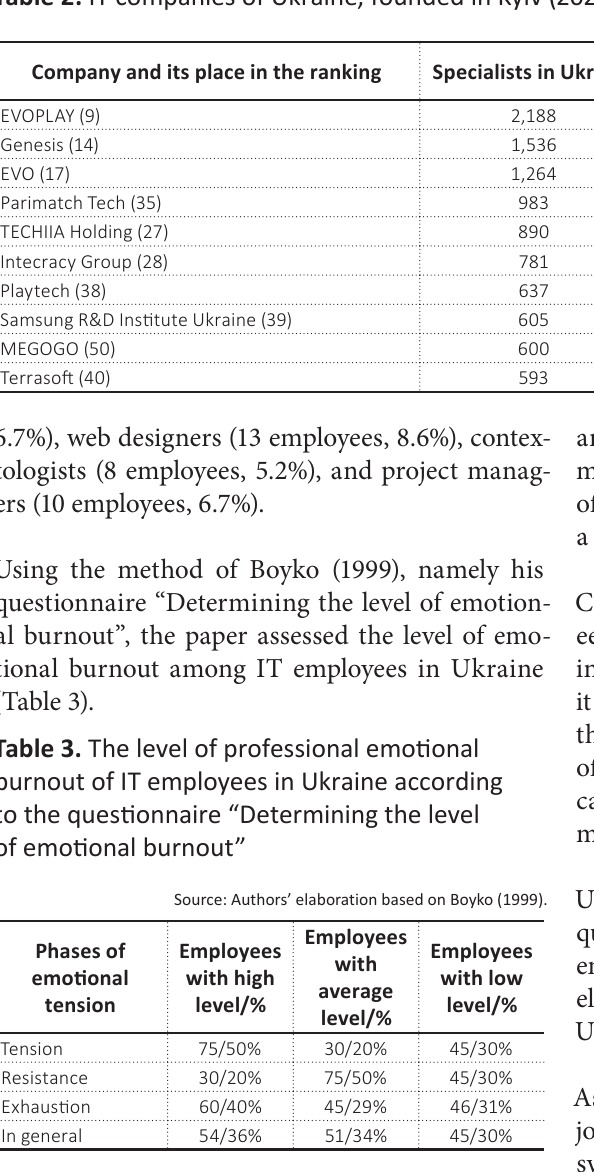
Table 2. IT companies of Ukraine, founded in Kyiv